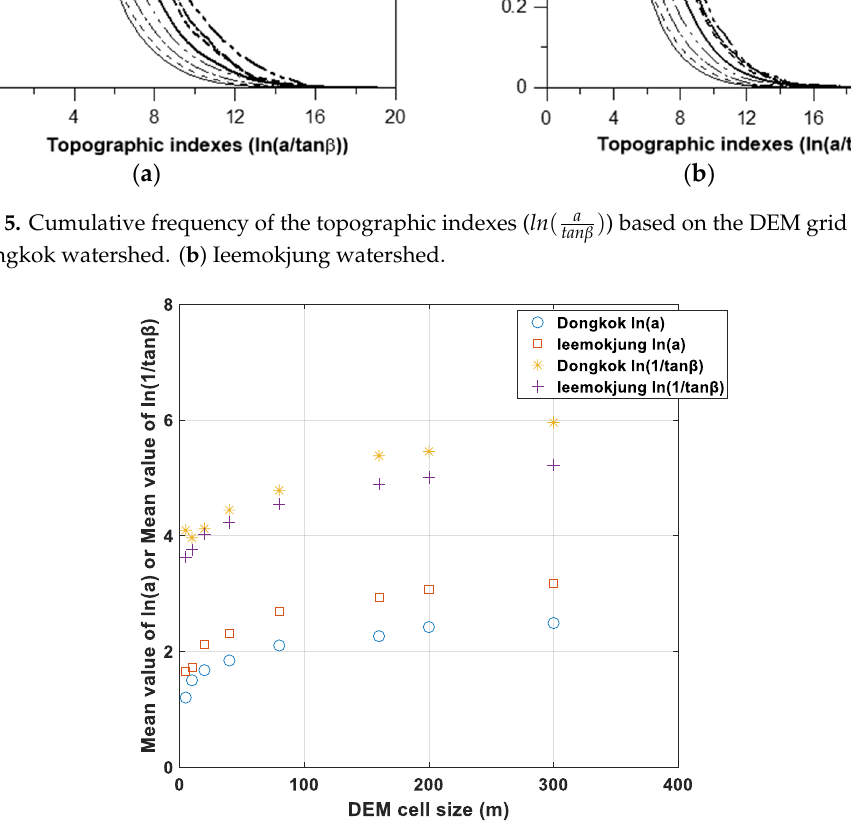
Figure 6. Relation of mean topographic indexes (l n ( a based on DEM cell size in Dongkok and Ieemokjung watersheds.